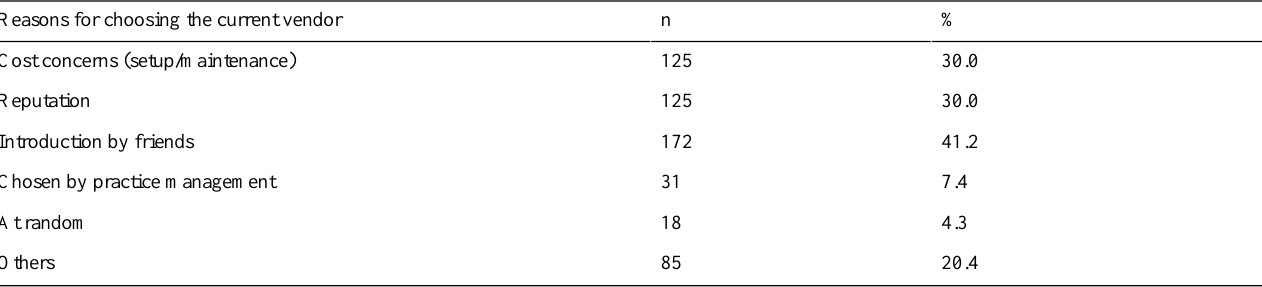
Table 2. Study participants’reasons for choosing the current vendors for eMR (N=524).